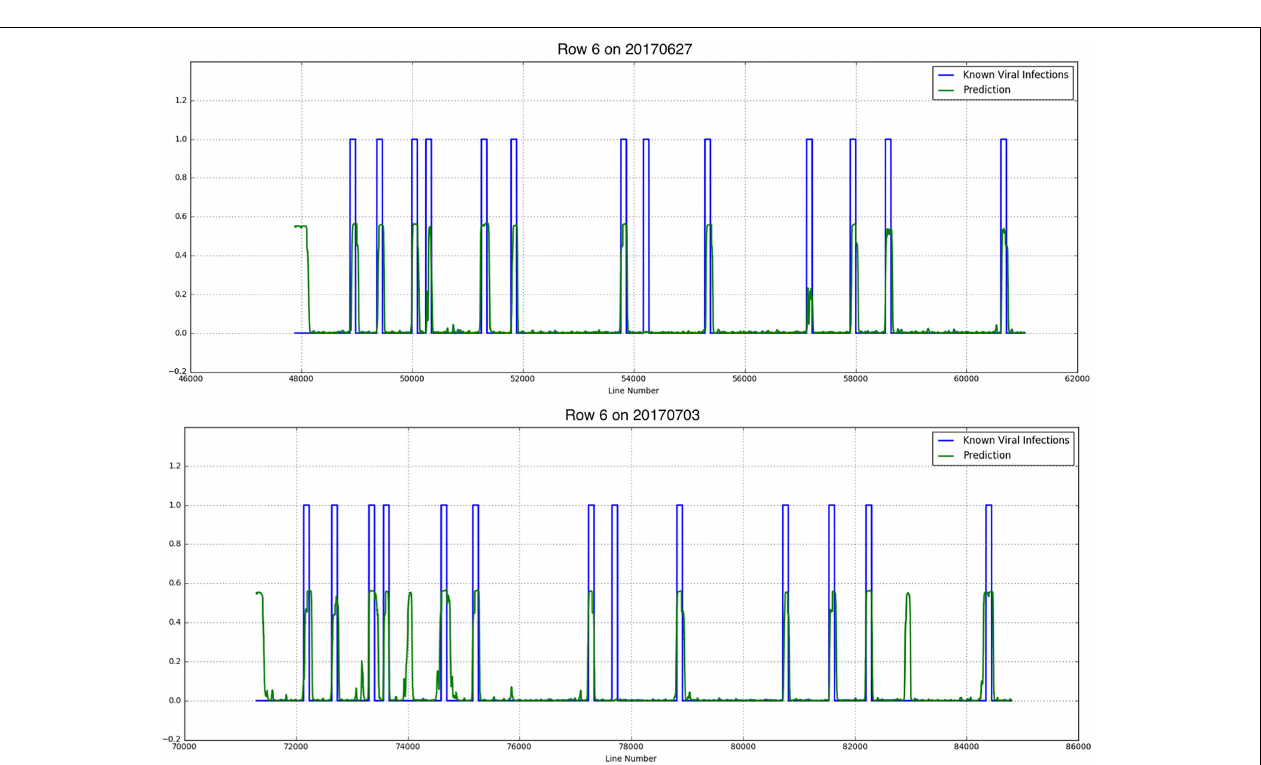
FIGURE 8 | Known PVY infection and CNN predicted infection for row 6 on 2017/06/27 and 2017/07/03.